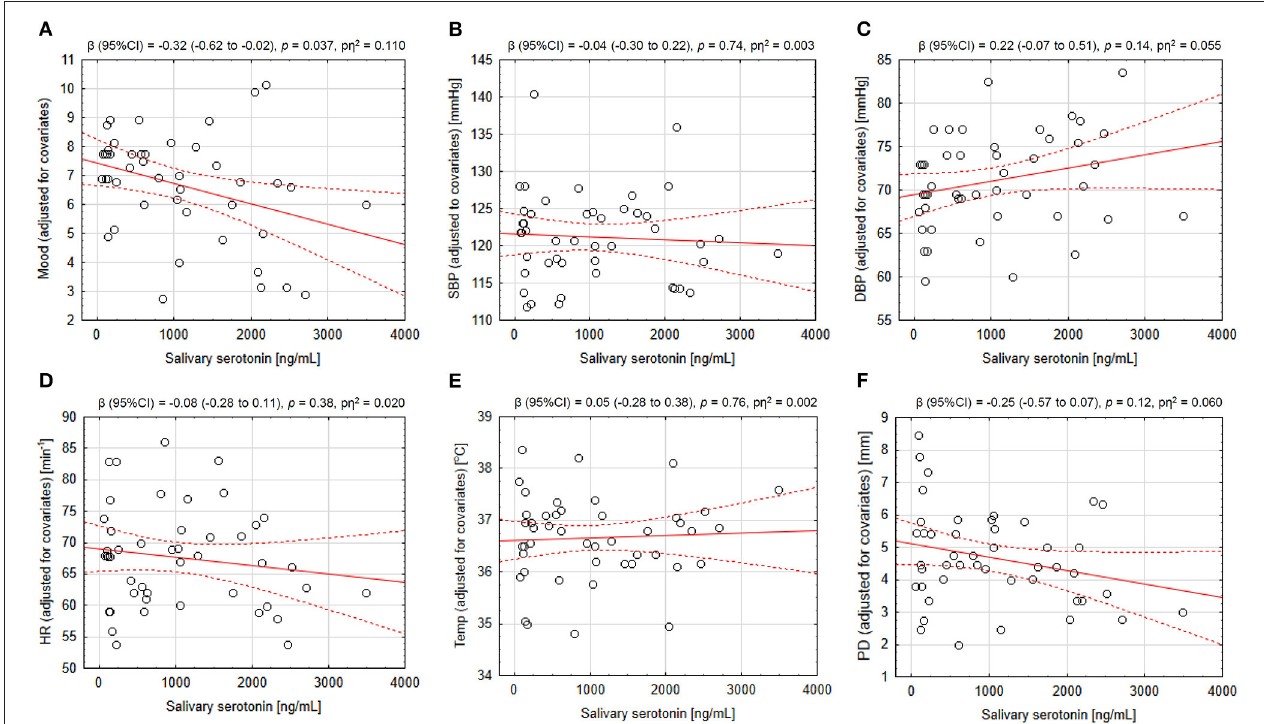
FIGURE 2 | Correlation between salivary serotonin concentration and the output parameters in adjusted analyses. Individual data points are presented with best fitted least-squares regression lines and their 95% confidence intervals. Regression coefficients, p -values for the associations and effect sizes expressed as partial eta-squared values are presented above each scatter plot. (A) Mood, (B) systolic blood pressure, (C) diastolic blood pressure, (D) heart rate, (E) body temperature, and (F) pupil diameter. SBP, systolic blood pressure; DPB, diastolic blood pressure; HR, heart rate; Temp, body temperature; PD, pupil diameter; p η 2 , partial